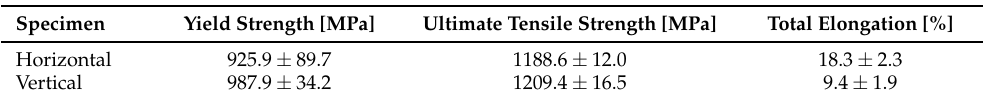
Table 4. Obtained mechanical properties of the deposited 18Ni300, according to two different specimen extraction configurations.